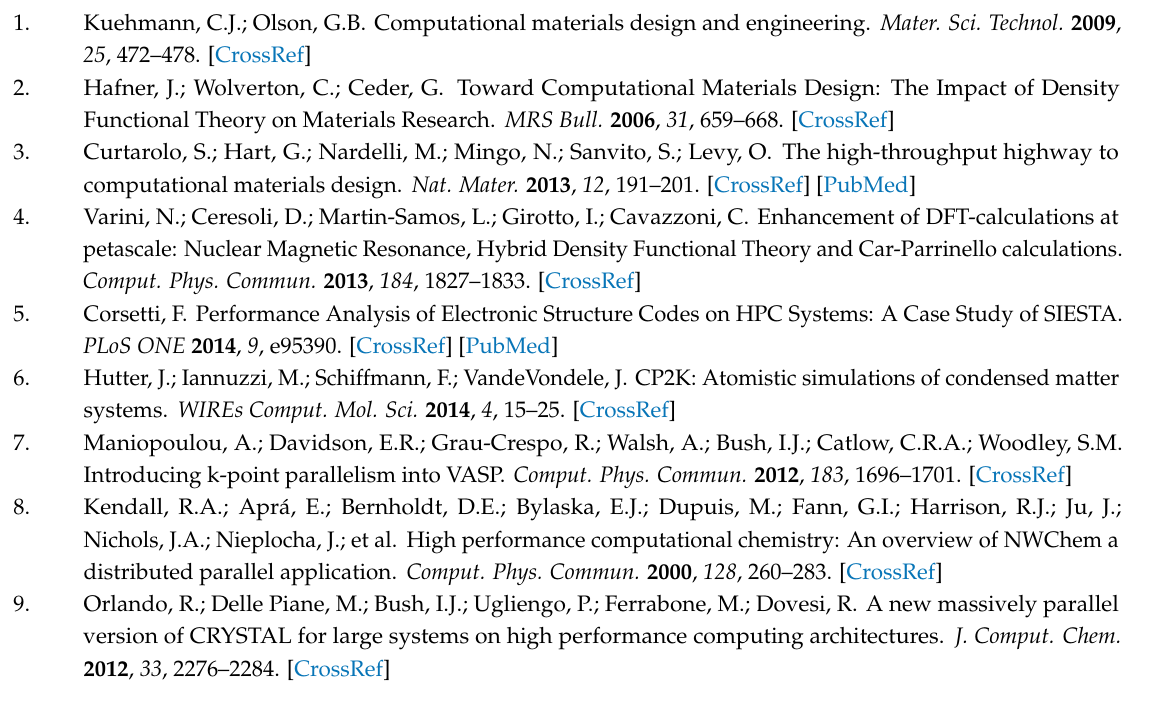
Figure S1: Isothermal versus adiabatic elastic constants of forsterite as a function of temperature; Figure S2: Low-valued adiabatic elastic stiffness constants of forsterite as a function of temperature; Figure S3: Thermo-elastic constants of forsterite as computed with the quasi-static